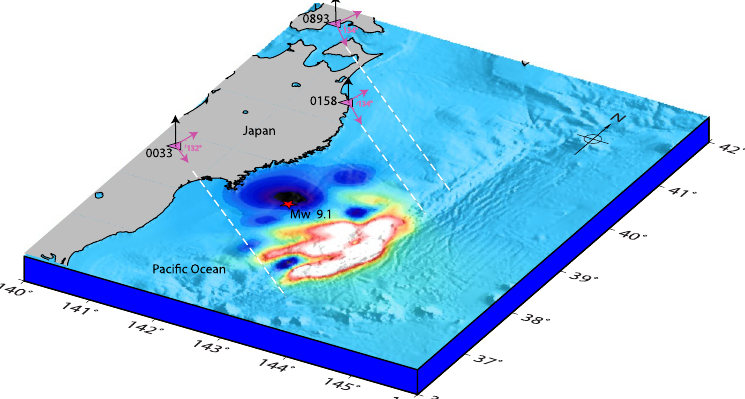
Figure 4. Realistic schematic showing PRN 05 azimuthal geometry from three GPS stations at their respective CIP recording times. Pink arrows denote the corresponding azimuth angle. GPS stations 0893 and 0158 were located north-north-west of the epicentre while 0033 was located in the west-west-north. The dashed white lines show the projection of PRN 05 LOS over the fault region, from the respective station. The figure is prepared using the GMT 5.4.1 43